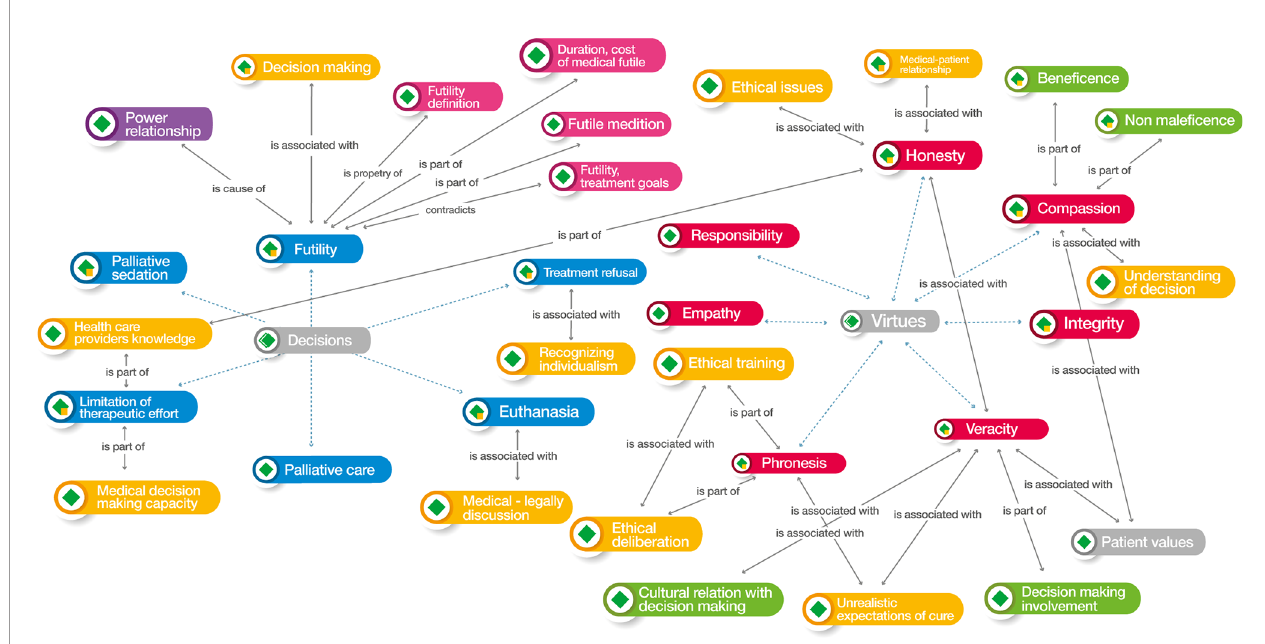
FIGURE 5 | Atlas.ti v.9 ® Medical decisions at the end of life and their relationship with virtues network. Color codes Groups: Blue: Medical decisions at End-of- Life; Red: Medical virtues; Yellow: Medical factors that in fl uence decisions; Dark green: Biomedical ethics principles; Green: Parents-patients ’ factors for decision-making; Grey: Patients factors for decision making; Violet: Medical barriers for decision making; Orange. Clinical determinants at end-of-life for decision-making; Pink: Futility